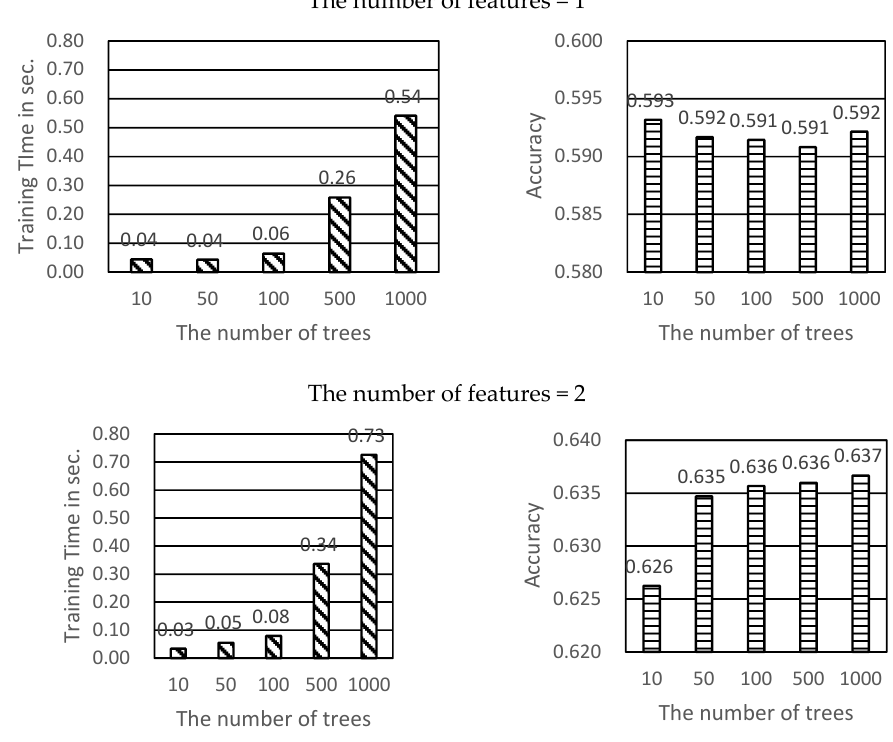
Figure 3. Predicting Modeling by default parameter value. Table 4. Comparison of Performance in Prediction